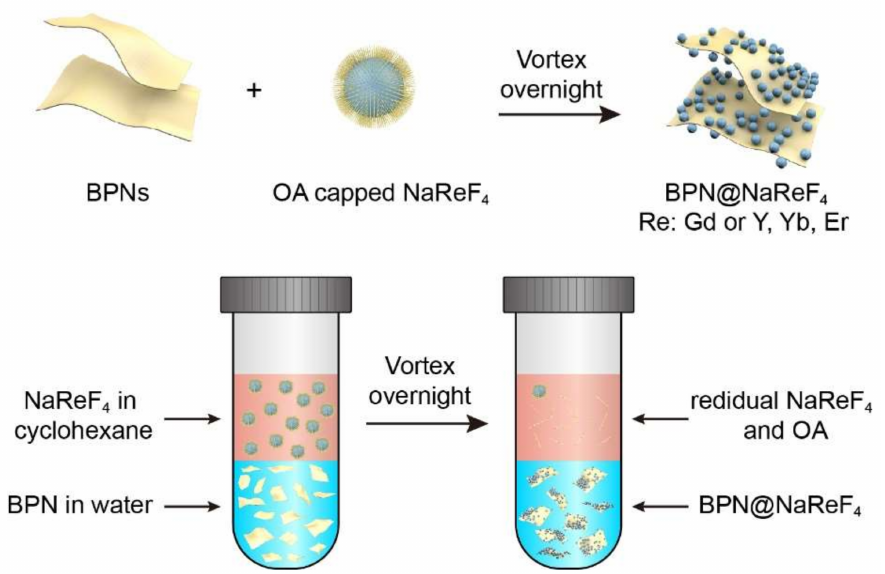
Figure 1. Schematic illustrations of BPN@NaReF 4 synthesis and corresponding experimental